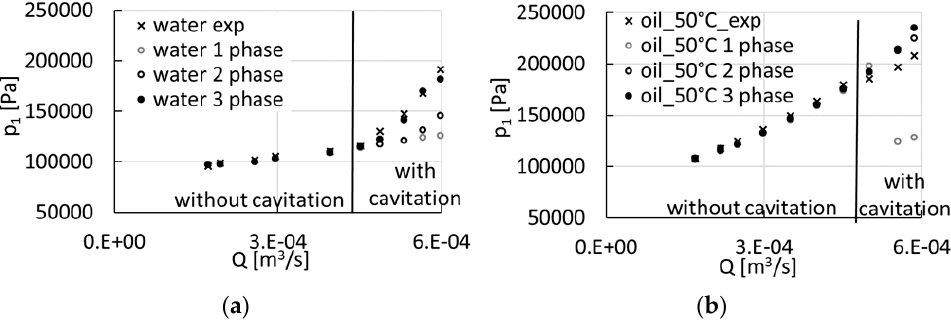
Figure 8. ( a ) Dependence of inlet pressure 𝑝 (cid:2869) (Pa) vs. volume flow rate 𝑄 (m 3 · s − 1 ) for water; ( b ) Dependence of inlet pressure 𝑝 (cid:2869) (Pa) vs. volume flow rate 𝑄 (m 3 · s − 1 ) for Oil.